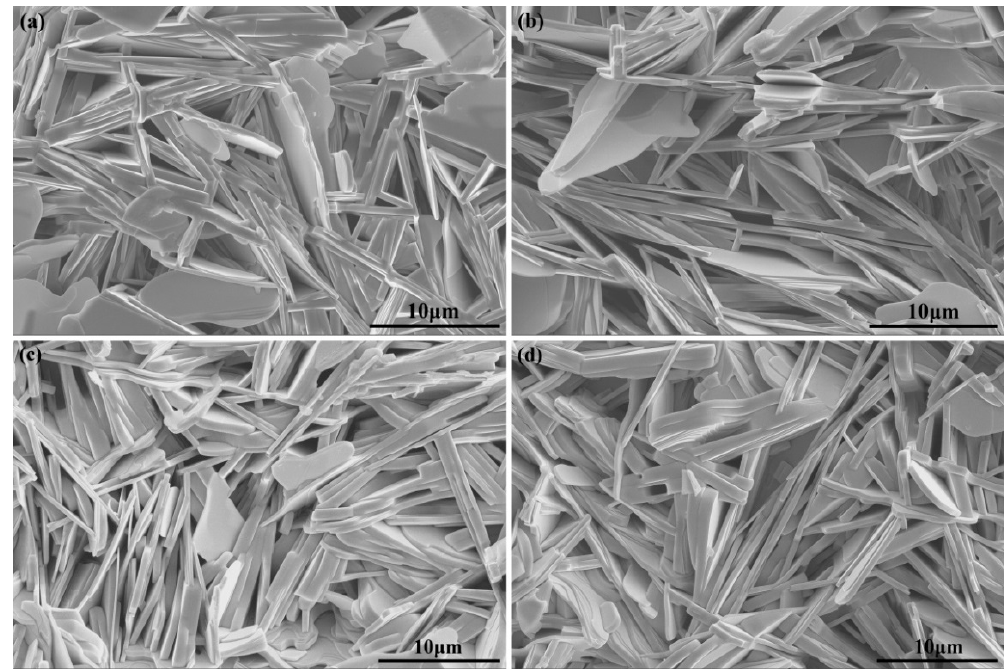
Figure 3. SEM images of samples. ( a – c ) SEM images of pure B(P)SCCO A1, B1, and C1 prepared from the raw materials S1, S2, and S3. ( d ) SEM image of B(P)SCCO doped with 0.4 wt% Y 2 O 3 :Eu 3+ +Ag (C7) prepared from the raw material S3.